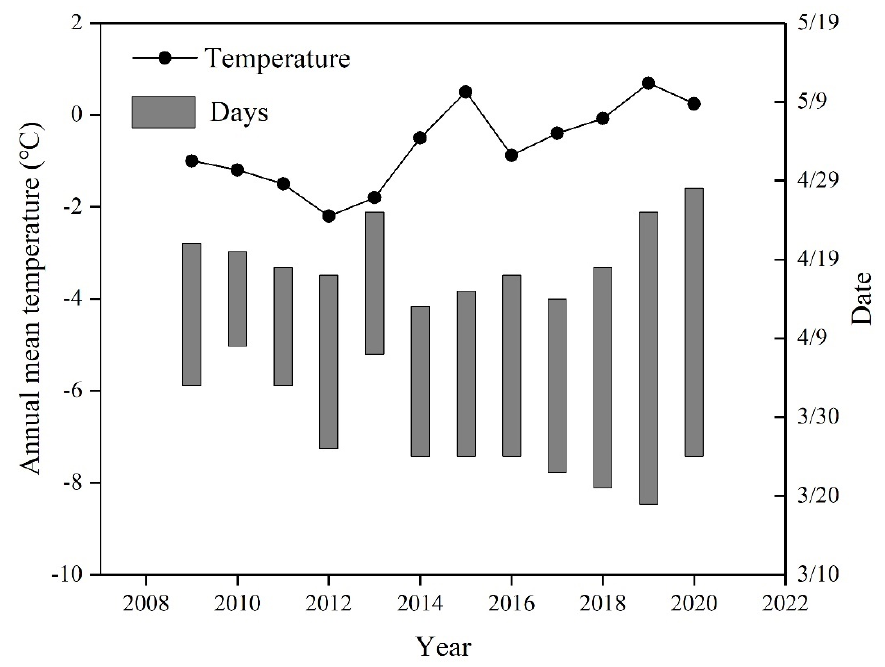
Figure 2. The annual mean temperature, start and end dates of the spring thaw period and the number of days of the spring thaw period from 2009 to 2020.